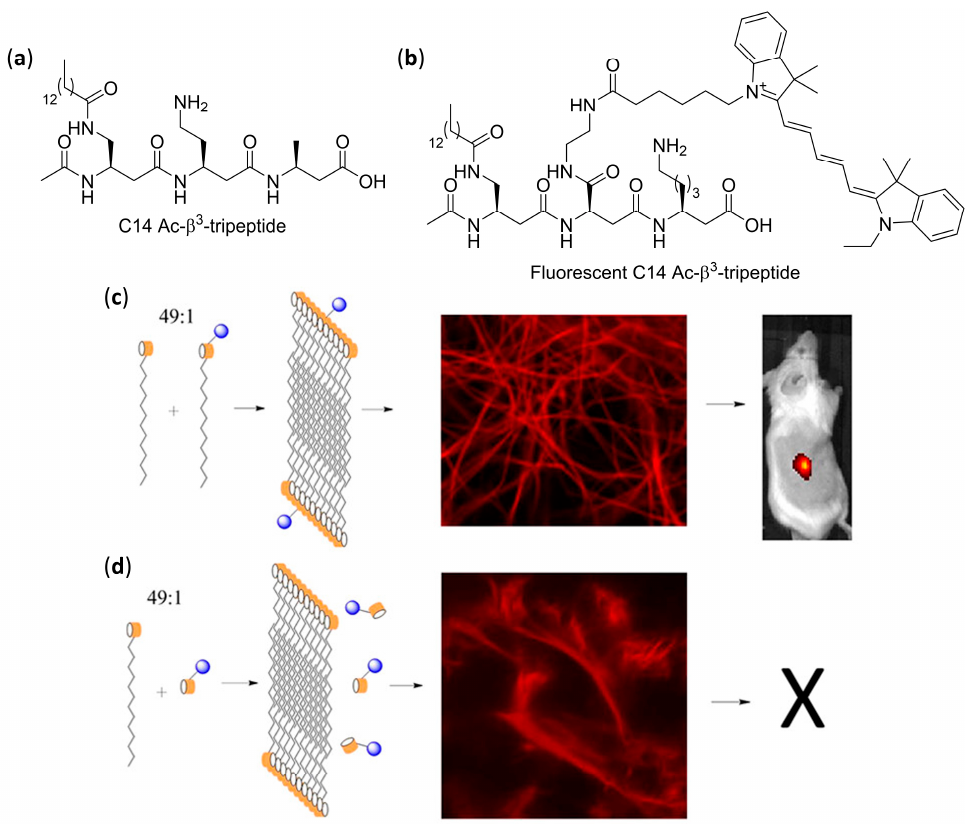
Figure 7. ( a ) The lipidated C14 Ac- β 3 -tripeptide (Refs. [123,125,130]) and ( b ) its fluorescent analogue (Ref. [129]); ( c ) From left to right: schematic representations of fibers formation by 49:1 mixtures of lipidated C14 Ac- β 3 -tripeptide and its fluorescent analogue; confocal image of the corresponding hydrogel showing successful incorporation of the fluorophore into the fiber matrix; in vivo animal imaging 14 days post-injection (ochre cylinders: Ac- β 3 -tripeptide skeleton; zigzag chains: C14 acyl chain; blue spheres: Quasar ® 670 emitting dye) (reprinted with permission from Ref. [129]); ( d ) The fluorophore was not incorporated into the fiber matrix when a 49:1 mixture with the non-lipidated version of fluorescent Ac- β 3 -tripeptide was used (reprinted with permission from Ref. [129]).